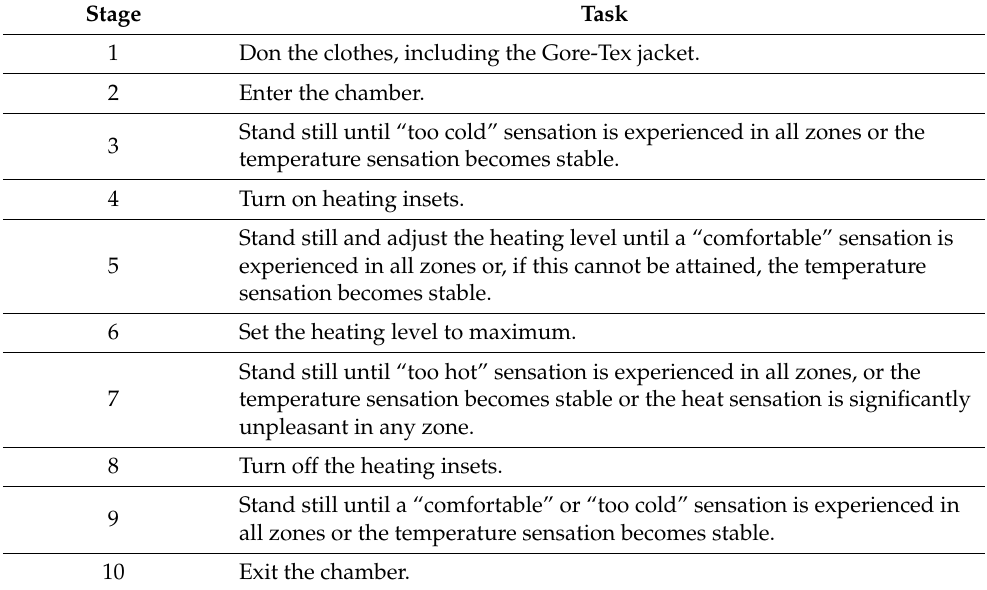
Table 2. Sequence of events of the experiment.